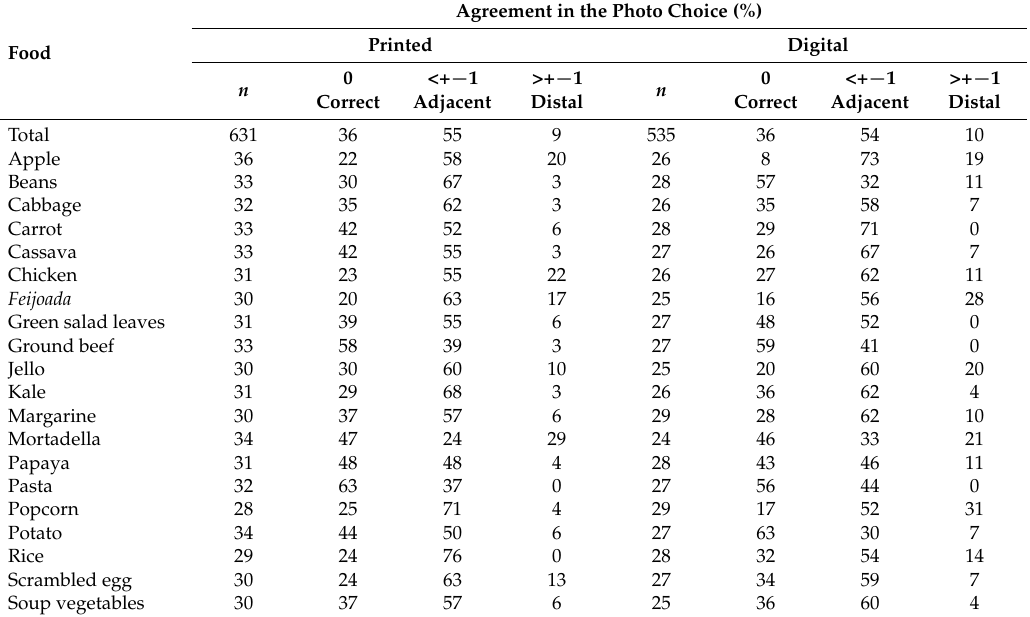
Table 2. Classification of the choice of printed and digital photos in the perception of food photos